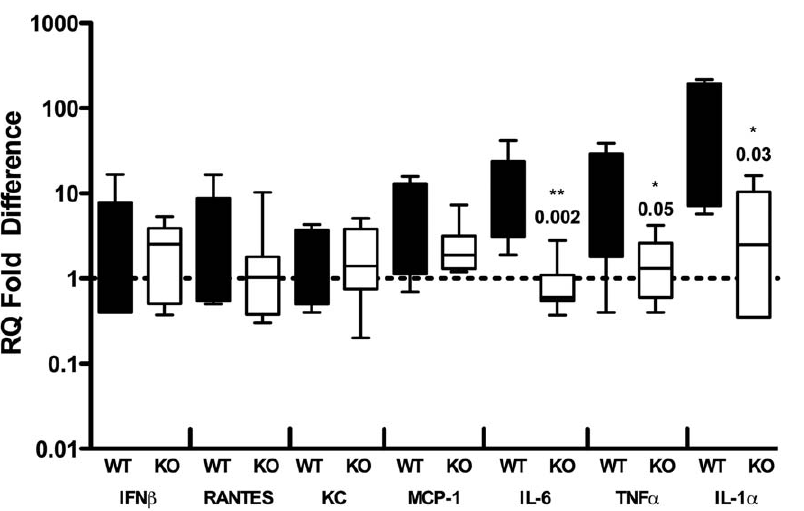
Figure 5. Enhanced bladder inflammatory responses to WT compared to b H/C-deficient GBS. Bladder tissue from WT-infected (filled boxes) animals was assessed by qRT-PCR at 24 h and demonstrated increased transcription of IL-6, IL-1 a and TNF- a compared to those receiving D cylE GBS (empty boxes). Data were compared using Mann-Whitney U test; P values are indicated atop the boxes where appropriate.